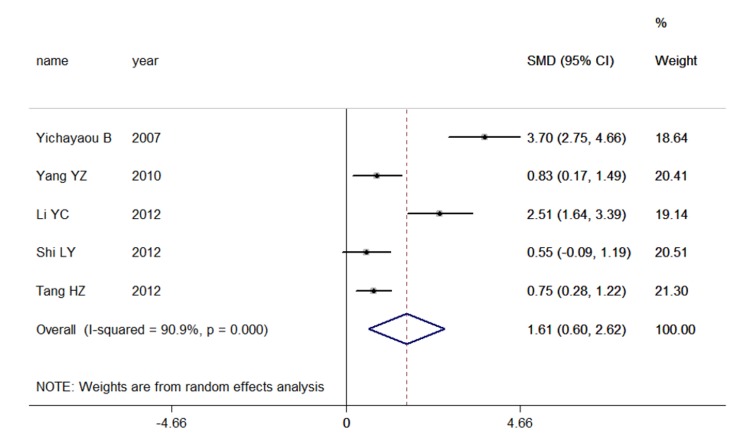
Studies of peripheral blood IL-6.Forest plot for IL-6 displaying the results of the random-effects meta-analysis for the association between peripheral blood IL-6 concentrations and POCD. The standardized mean difference is presented on the horizontal axis; positive values denote higher serum levels in patients; negative values denote higher serum levels in control subjects. The dashed line is at the overall weighted mean difference. CI, confidence interval; SMD, standardized mean difference.